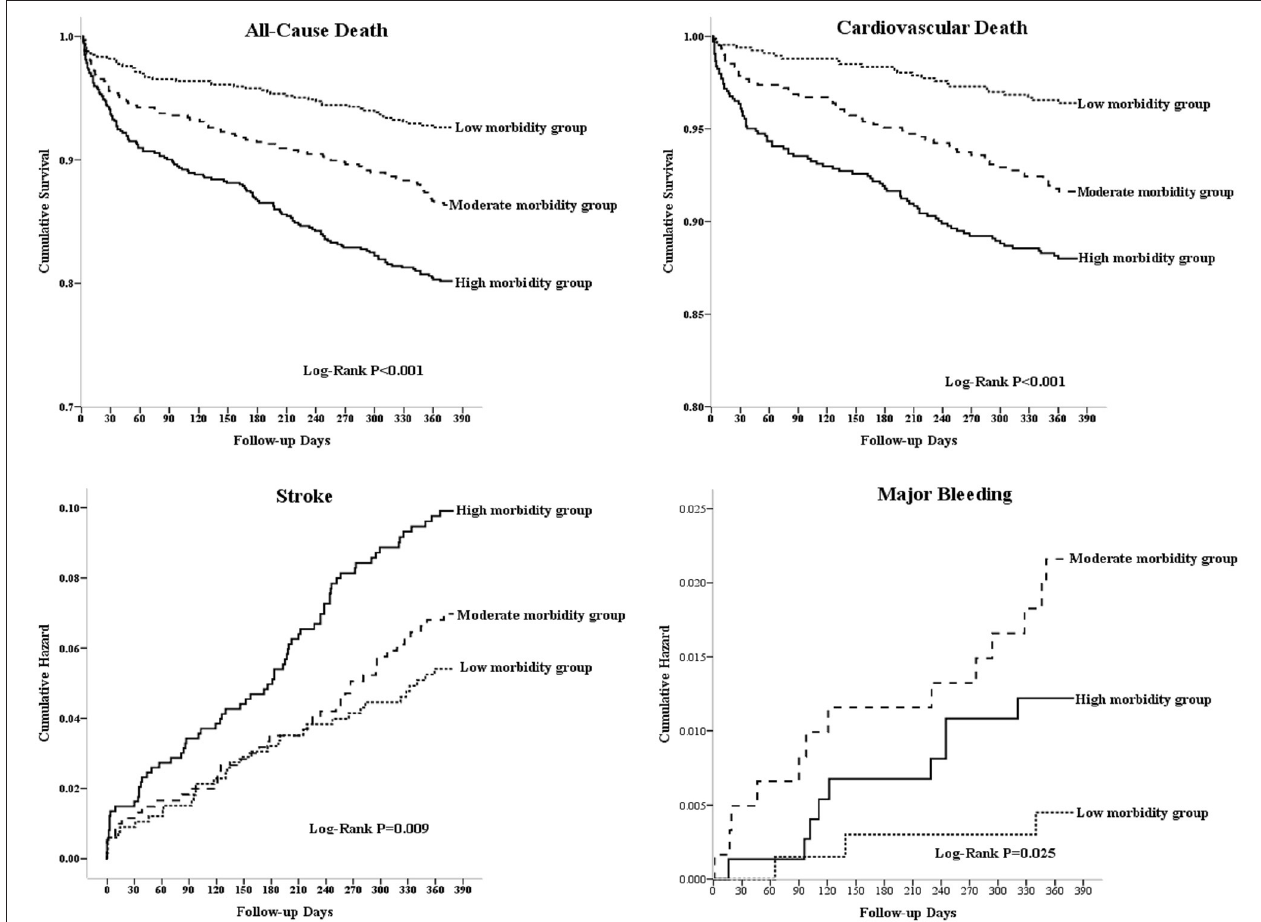
FIGURE 2 | The Kaplan-Meyer survival curves and event rates for all-cause death, cardiovascular death, stroke, and major bleeding in patients with AF according to the morbidity